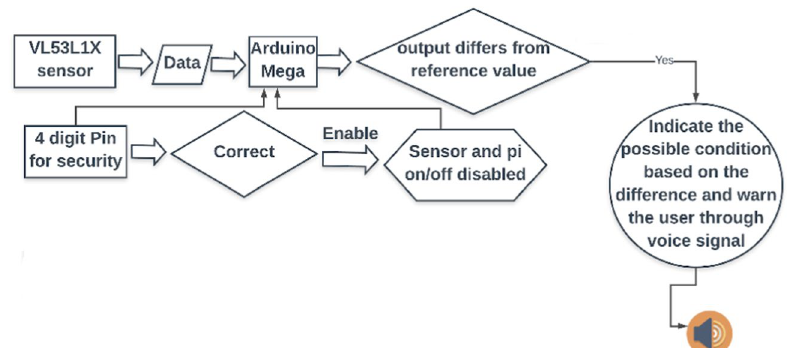
Fig. 5 The working flow of the Blind’s apron for uneven surface detection